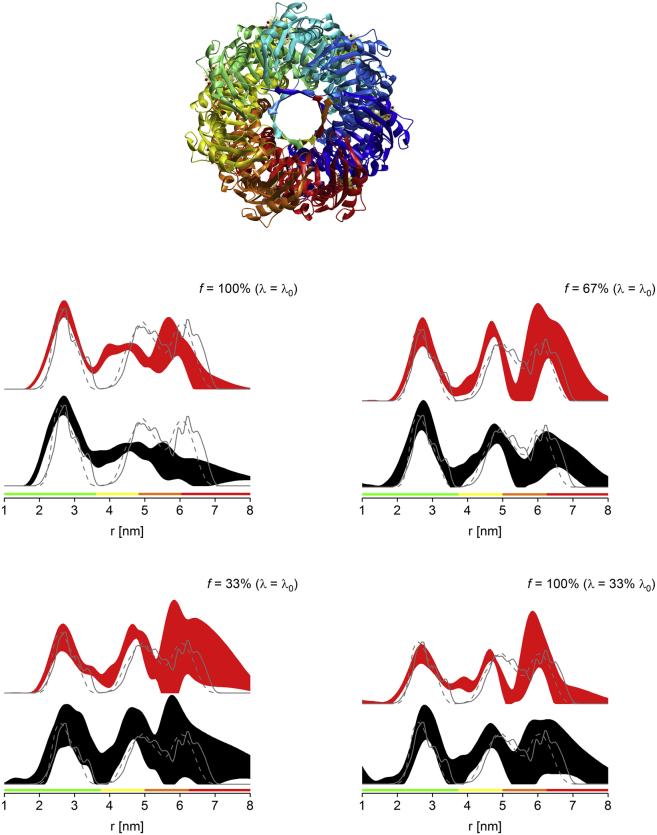
MscS D67R1 PELDOR distance distributions obtained for fully labeled protein (middle left), sparsely labeled protein (bottom left, f = 33%; middle right, f = 67%), and λ-reduced fully labeled protein (bottom right, λ = 33% λ0). See Fig. 1 for details on the 2σ confidence intervals, predicted distance distributions, and color bars. See Supporting Material for raw PELDOR data and processing. (Top) Shown here is the MMM model of fully labeled protein. To see this figure in color, go online.